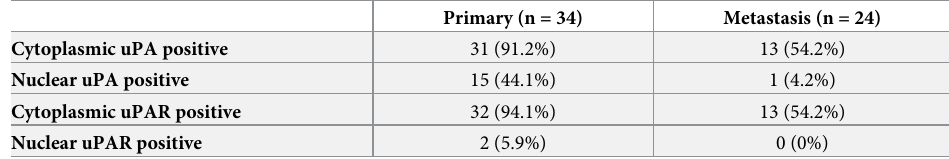
Table 4. uPA and uPAR positivity in primary and metastatic osteosarcoma.